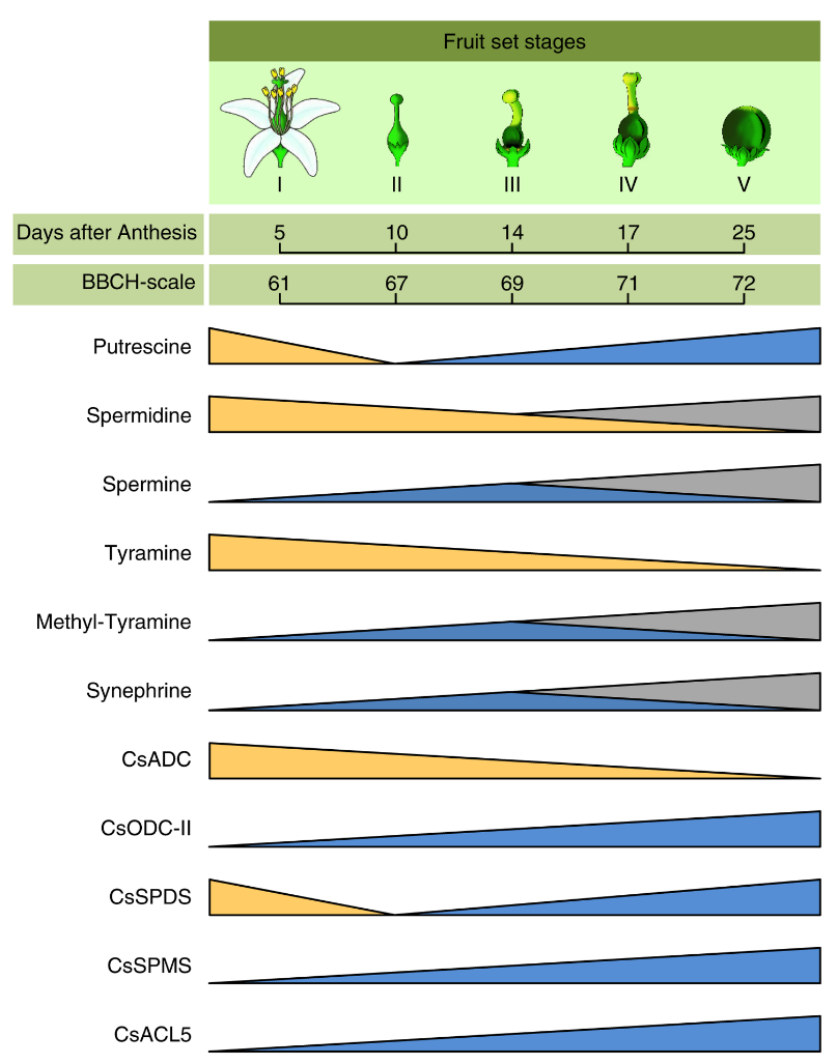
Figure 6. Schematic overview representation of the metabolic behaviors of polyamines (PAs), some other nitrogen-containing metabolites, and the major PAs-biosynthetic genes during the fruit set and development of citrus plants. Fruit set stages (61, 67, 69, 71, and 72) are corresponding to the phenological growth stages on BBCH-scale [149,150]. Yellow bars / triangles represent the reduction in the metabolite levels or down-regulation in gene expression, blue bars / triangles represent the increase in metabolite levels or up-regulation in gene expression, while gray bars / triangles represent the controversial behavior in metabolite levels. For more details, see the main text.